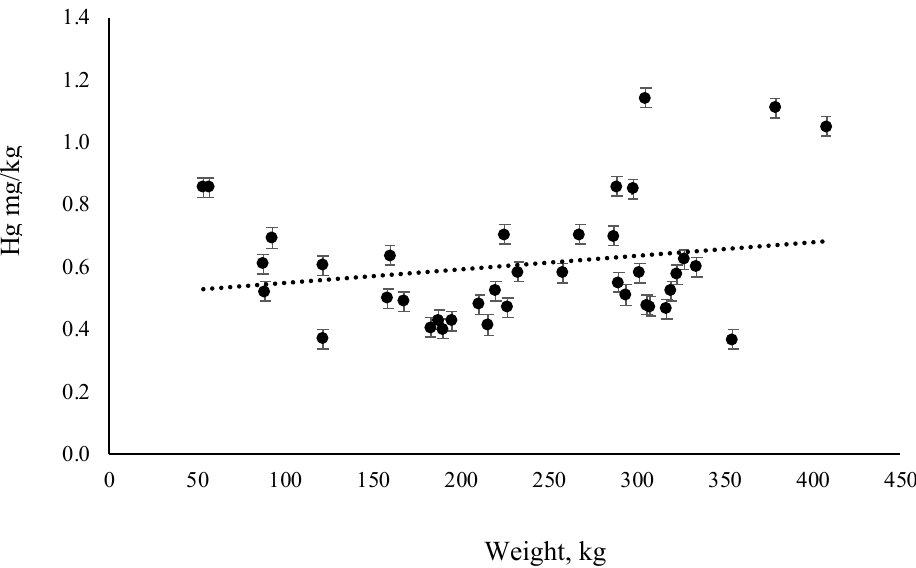
Figure 2. Relationship between Hg concentration (mg/kg w.w.) and body weight (kg) in farmed tuna.